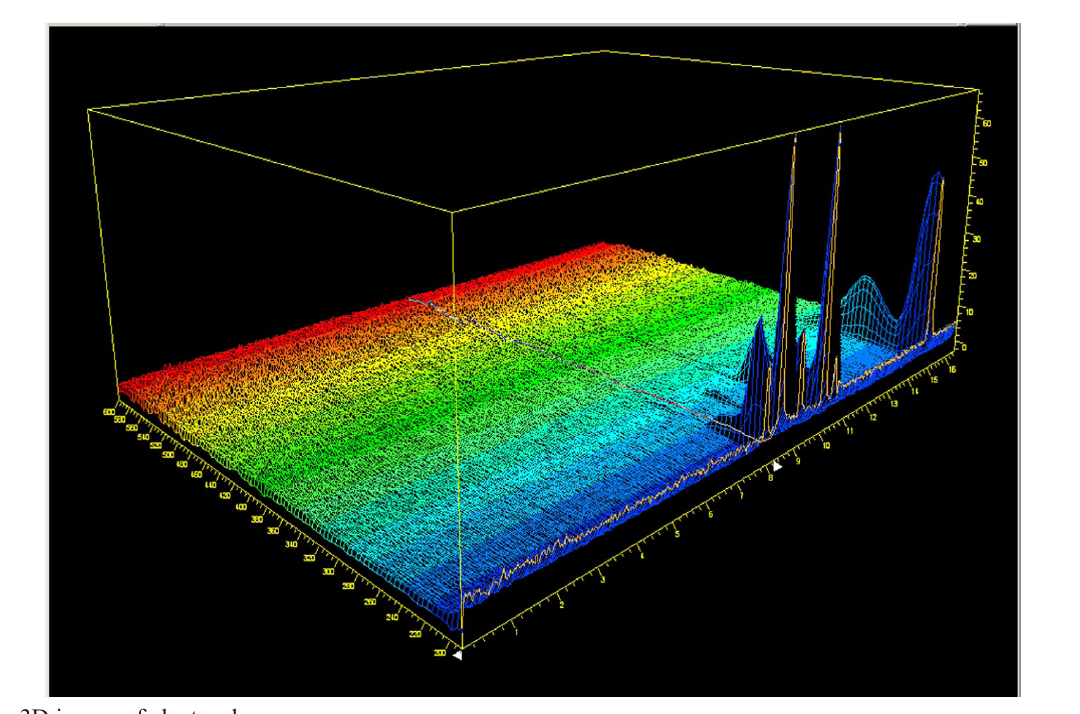
Figure S5 - 3D image of electropherogram TABLE I - O ptimization parameters BGE